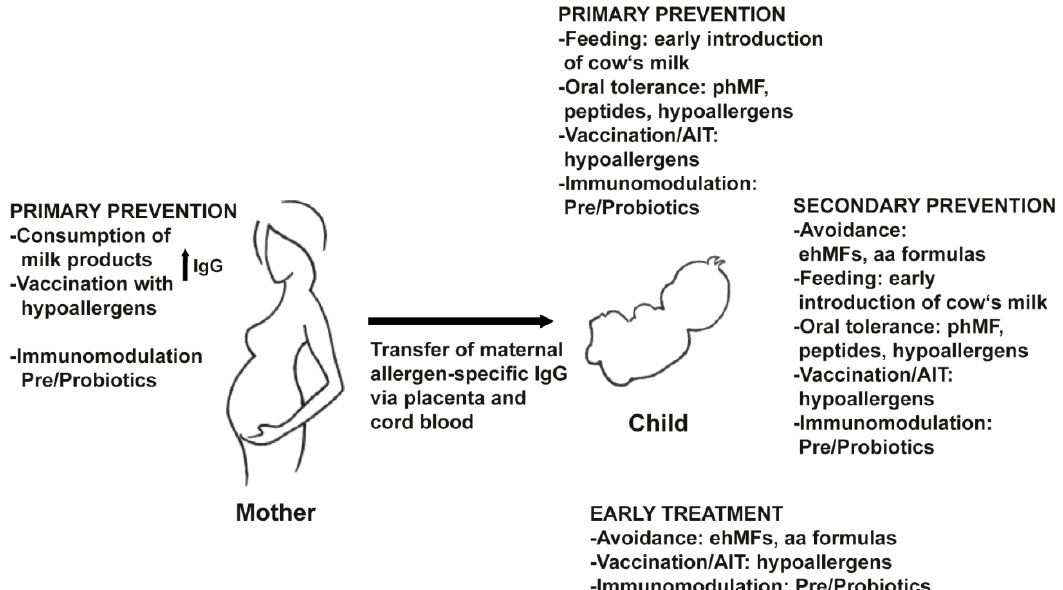
Figure 2. Primary, secondary prevention, and early treatment of cow’s milk allergy. Primary prevention strategies can be applied to the mother and the child to avoid allergic sensitization to cow’s milk allergens. The progression of the disease in sensitized children, or those who have already developed allergic symptoms, is inhibited by secondary prevention strategies or early treatment.